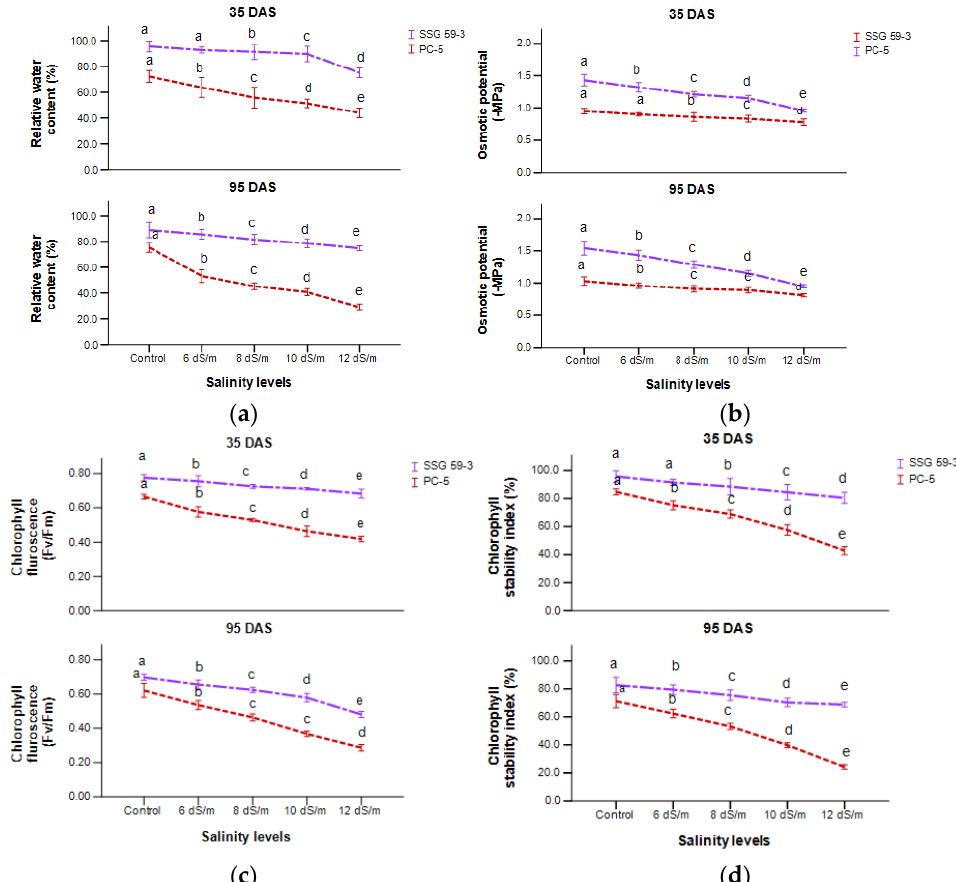
Figure 3. Effect of salt stress on relative water content, ( a ) osmotic potential, ( b ) chlorophyll fluorescence, and ( c ) chlorophyll stability index ( d ) of sorghum genotypes at 35 and 95 DAS. Post hoc comparisons of the means were performed using Tukey’s HSD test at p < 0.05; different letters ( a–e ) indicate significant differences among treatments within each genotype.